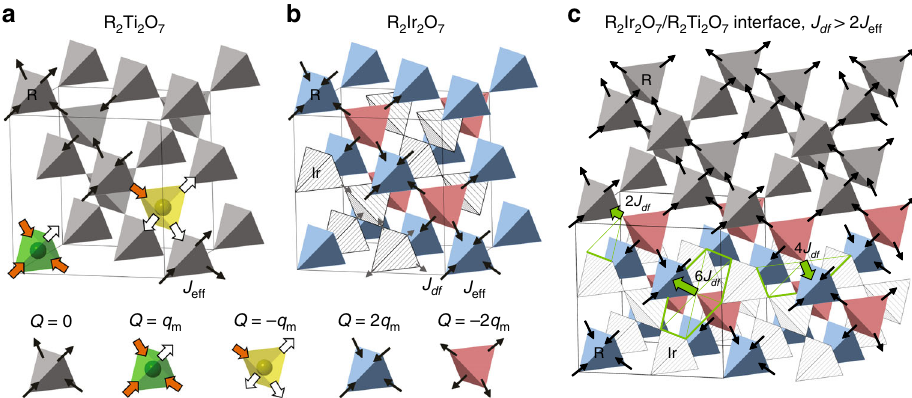
Fig. 1 Lattice and spin structure of pyrochlore spin ice, antiferromagnet, and their interface. a , b Illustrations of lattice and spin structures of a spin ice pyrochlore R 2 Ti 2 O 7 and an antiferromagnetic pyrochlore R 2 Ir 2 O 7 respectively, where the nearest neighbor interaction between R 3 + moments J eff and the d – f interaction between a R 3 + moment and an Ir 4 + moment J df are shown. The arrows represent the local moments. The tetrahedral sites with magnetic charge Q = 0 are in gray, Q = q m in green, Q = − q m in yellow, Q = 2 q m in blue, and Q = − 2 q m in red. c Illustration of lattice and spin structure of an R 2 Ir 2 O 7 /R 2 Ti 2 O 7 interface with J df > 2 J eff , where the spin ice layer are forced to adopt a fully polarized state. The complete/truncated Ir 4 + hexagons are highlighted in green and the complete/reduced local exchange fi elds experienced by the R 3 + moments are materialized by green